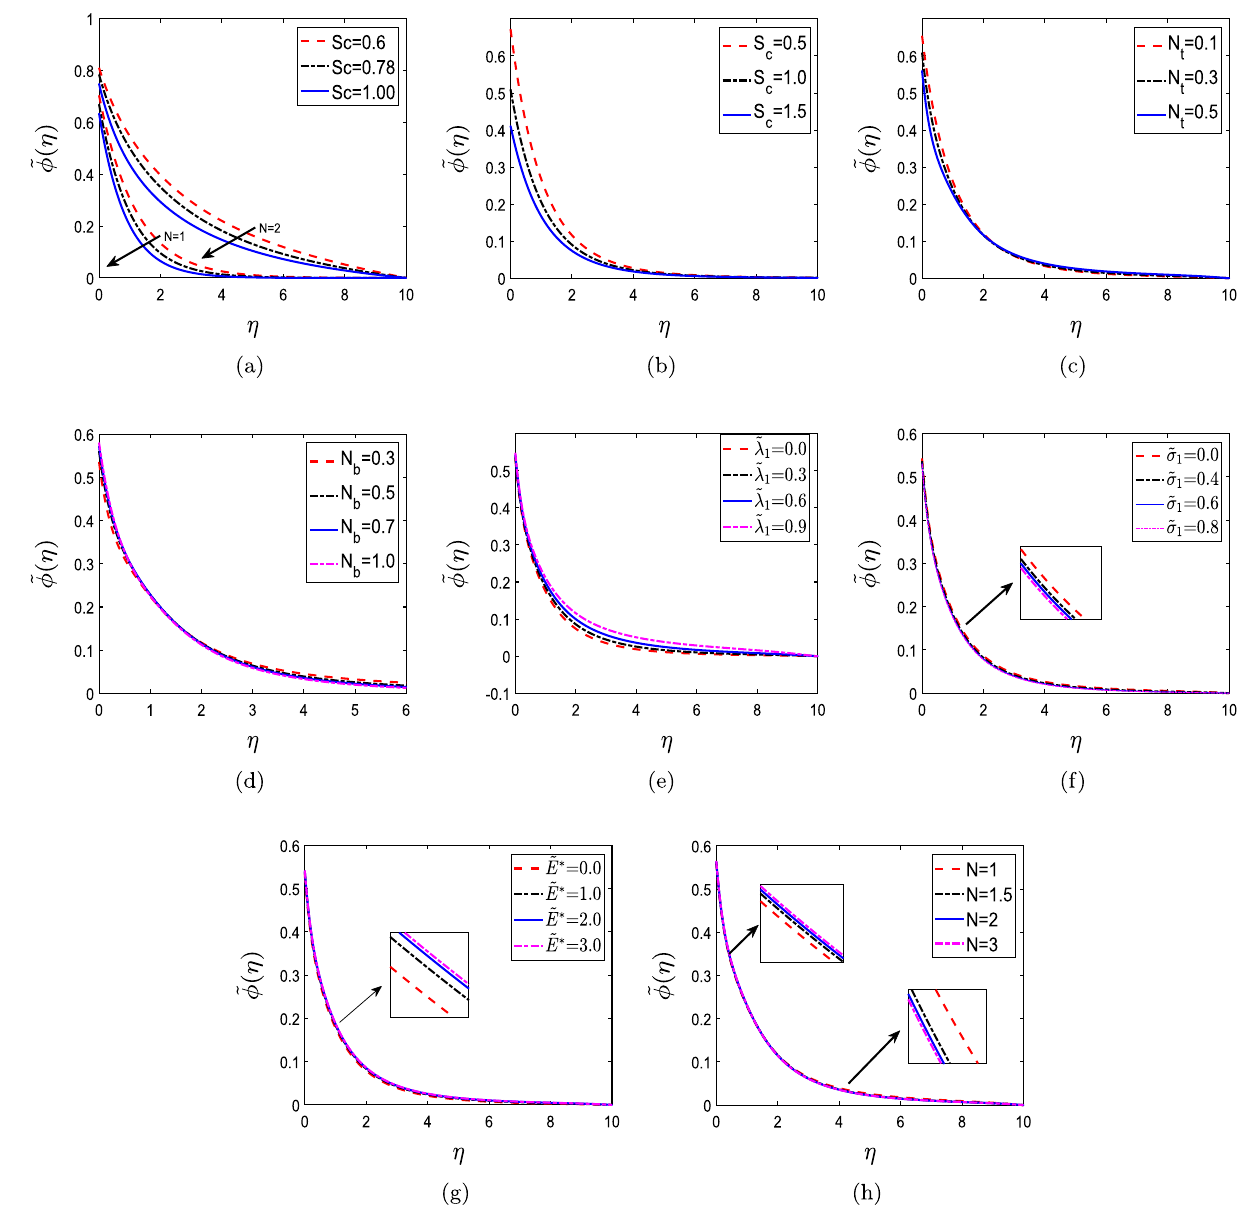
Figure 7. Non-dimensional concentration profiles for ( a ) Schmidt number (Sc), ( b ) concentration slip ( S c ), ( c ) thermophoresis parameter ( N t ), ( d ) Brownian motion parameter ( N b ), ( e ) endothermic/exothermic reaction ˜ (cid:31) parameter ( 1 ), ( f ) chemical reaction parameter ( ˜ σ 1 ), ( g ) activation energy parameter ( chemical reaction